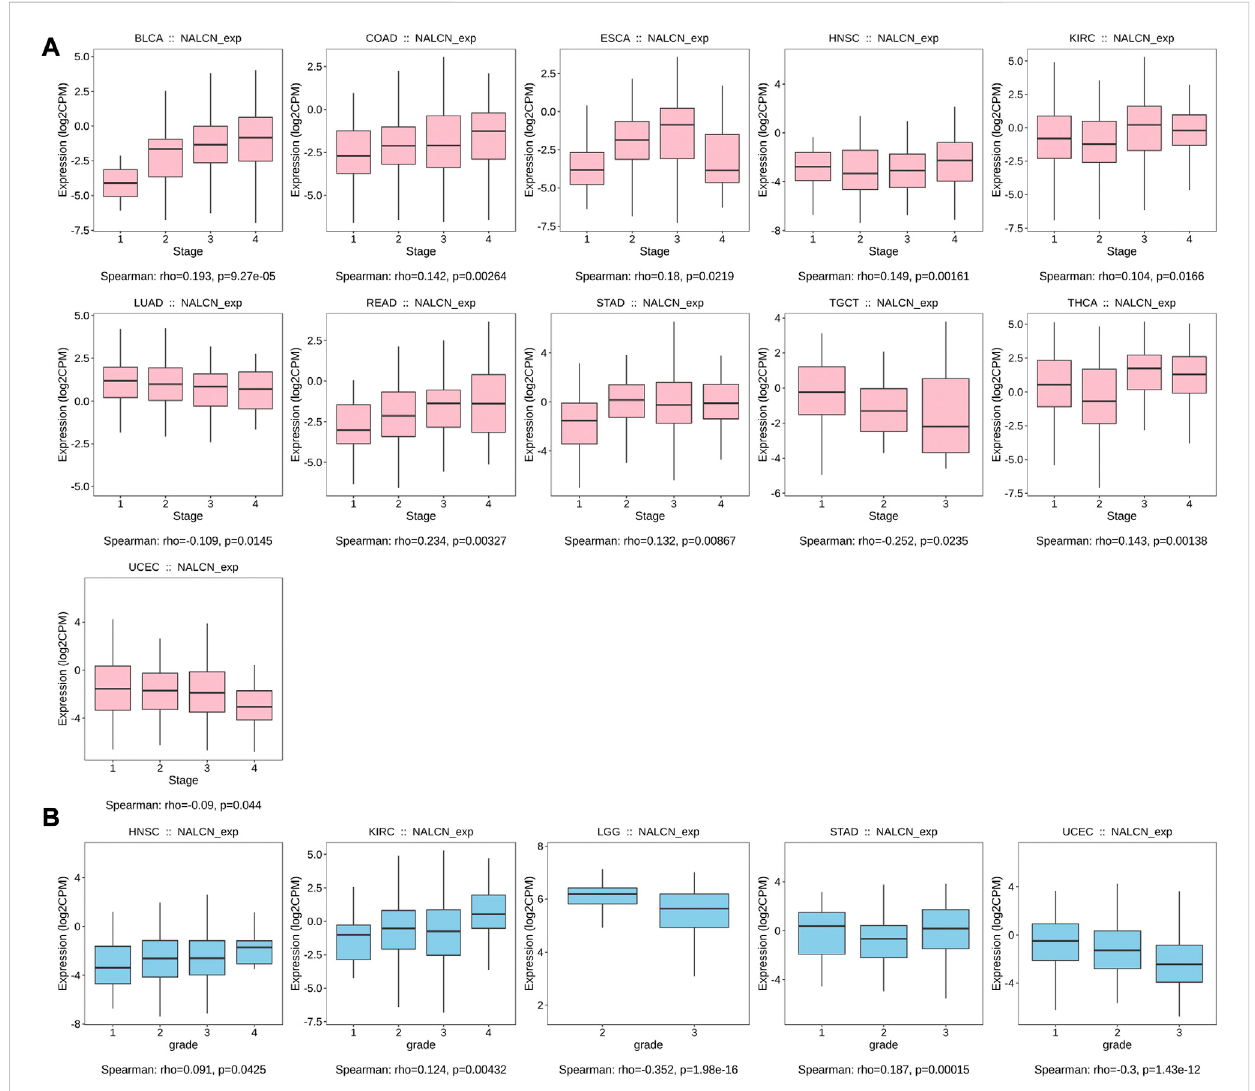
FIGURE 4 Correlation of NALCN expression and clinicopathological parameters (stage, grade) across different cancer types. (A) Correlation of NALCN with stagesofBLCA,COAD,ESCA,HNSC,KIRC,LUAD,READ,STAD,TGCT,THCA,UCEC, basedontheTISIDBdatabase. (B) Correlation ofNALCNwithgrades of HNSC, KIRC, LGG, STAD, UCEC, based on the TISIDB